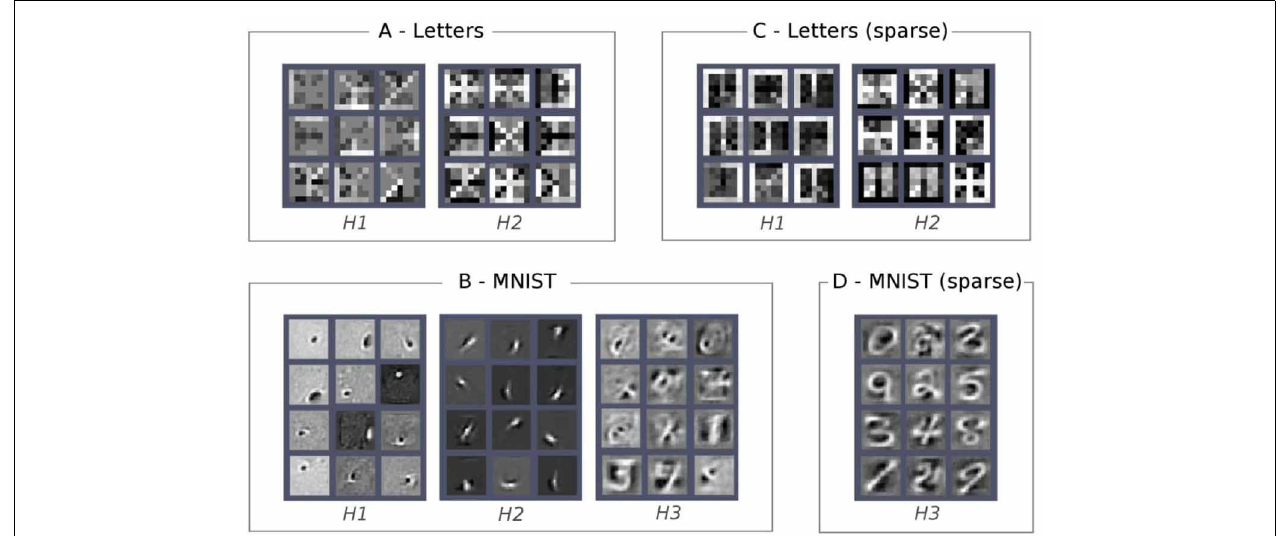
FIGURE 6 | Visualization of features learned at different hidden layers ( H i ). Each square within a layer represents the receptive field of one hidden unit. Excitatory connections are shown in white, whereas inhibitory connections are in black. (A) H1 and H2 on single letters (pixelated “Siple